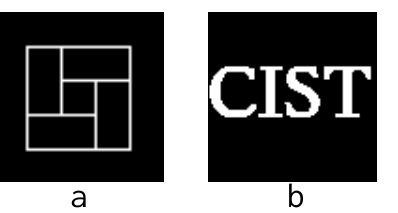
Figure 1. ( a ) Rectangular target irradiance distributions, ( b ) the characters “CIST” target irradiance distributions.